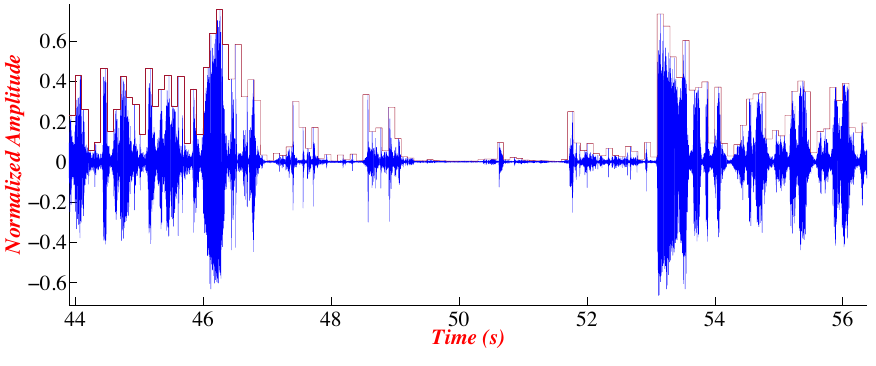
Figure 3. Zoom on original audio signal with